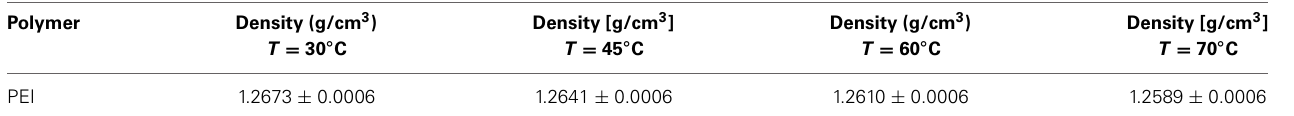
Table 5 | Density values (g/cm 3 ) of the amorphous PEI calculated at the four temperatures of interest based on the value of density of amorphous PEEK measured at 25 ◦ C and on the volumetric thermal expansion coefficient available in the literature.